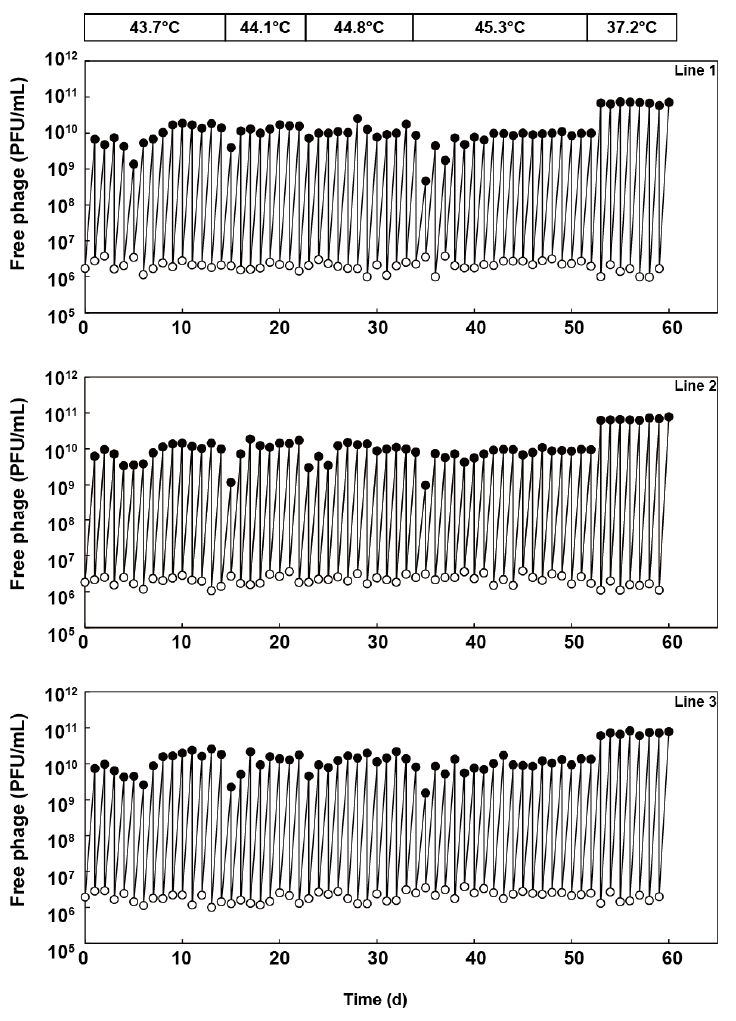
Figure 2. Population dynamics of the three independent Qβ lines in thermal adaptation. Population dynamics of the free-phage densities (PFU/mL) of lines 1, 2, and 3 are as shown. The free-phage densities immediately after (0 h) and at 5 h after infection were measured each day using the method described in the Materials and Methods section. We performed fitness analysis at 37.2 °C, 43.7 °C, 44.8 °C, and 45.3 °C using the 12 endpoint populations noted above (Figure 3). Relative fitness was calculated as the ratio of free bacteriophage concentrations (PFU/mL) at 5 h and 0 h, respectively. Fitness analysis revealed that at 45.3 °C, the thermally adapted Qβ populations could grow at 45.3 °C but 18 mut could not grow. At 37.2 °C, there